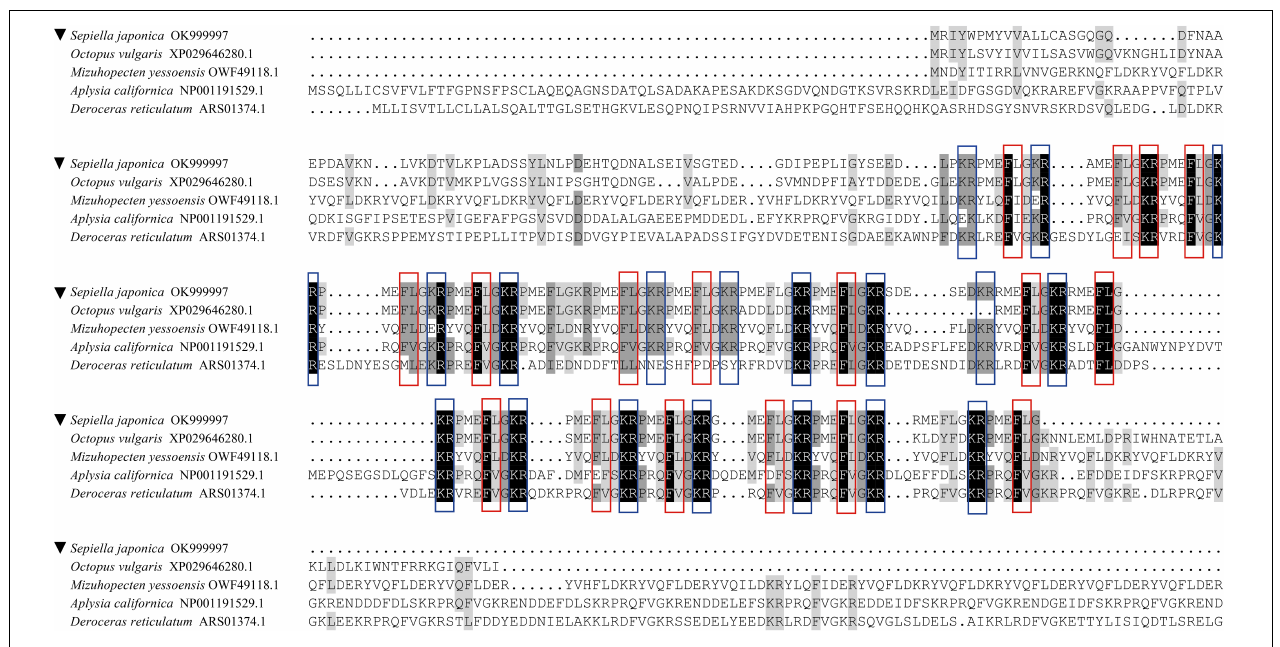
FIGURE 2 | Multiple alignments of the Sj PRQFVRP with PRQFVamide of other species. The Sj PRQFVRP is noted by (cid:72) . The GenBank accession numbers of the sequences are as follows: Sepiella japonica (OK999997), Octopus vulgaris (XP 029646280.1), Mizuhopecten yessoensis (OWF49118.1), Aplysia californica (NP 001191529.1), and Deroceras reticulatum (ARS01374.1). Identical residues in all sequences are showed with black boxes. Conservative substitutions are showed with gray boxes. The red boxes are used to indicate the conservative position in the predicted mature peptide (FX). The blue boxes are used to indicate the conservative cleavage sites